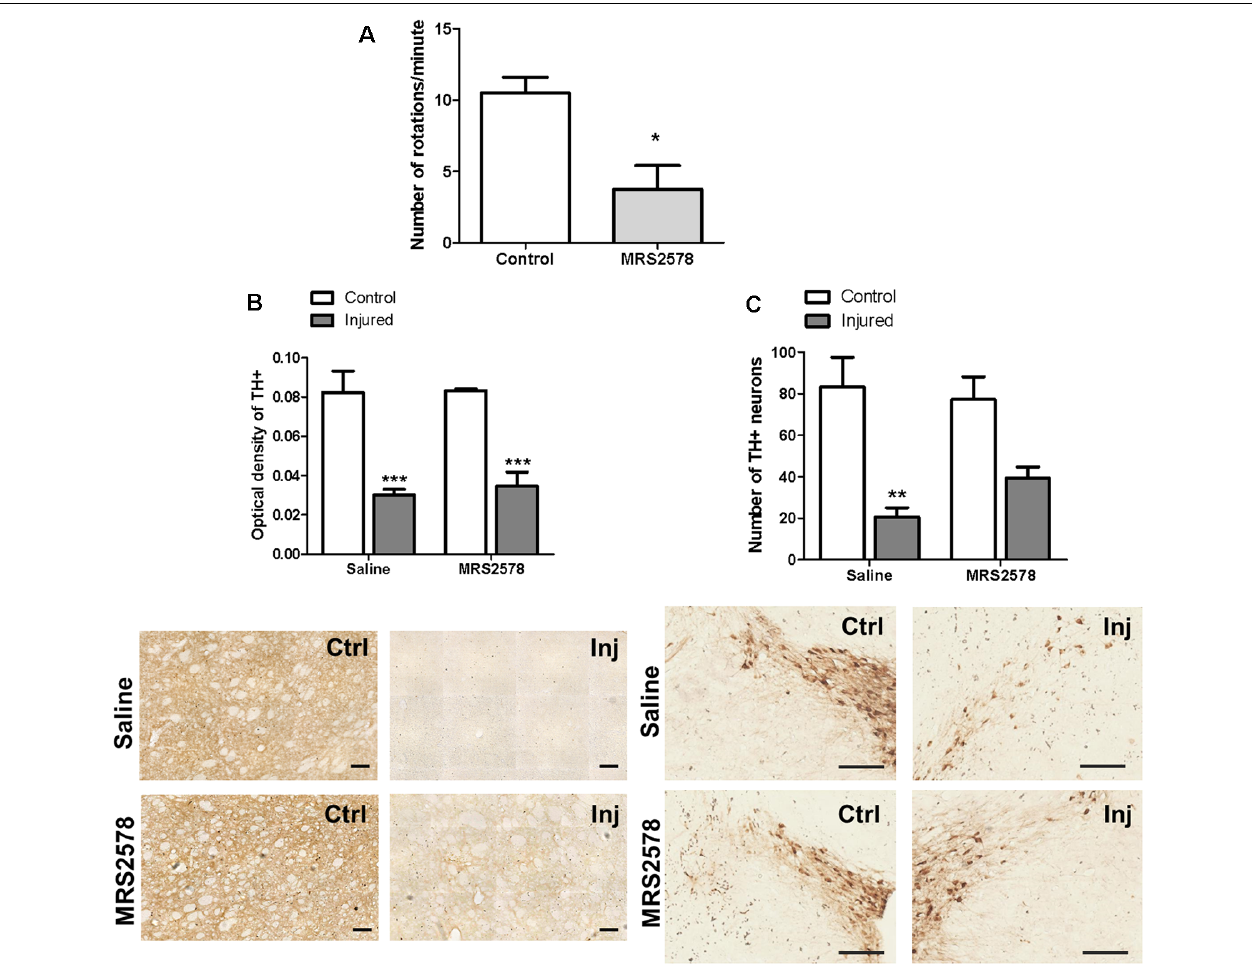
FIGURE 5 | Effect of MRS2578 treatment on 6-OHDA-injured rats. (A) MRS2578 at a dose of 2 µ g/kg was intrastriatally injected 10 min before ( n = 8) or 5 weeks after ( n = 5) the 6-OHDA at 7 µ g/kg injection. Animals were submitted to the apomorphine-induced rotational test after 1 week. ∗ p < 0.05 in relation to the number of pre-treatment rotations, F ( 2,18 ) = 4.299, p = 0.029. One-way ANOVA followed by the Tukey post hoc test. Immunohistochemical analysis of tyrosine hydroxylase labeling in the striatum (B) , measured as optical density, scale: 100 µ m, F ( 1,20 ) = 4.109, p = 0.056; and (C) in the substantia nigra , expressed by the number of neurons, scale: 200 µ m; F ( 1,20 ) = 7.751, p = 0.011. Control (Ctrl) and injured (Inj) hemispheres. Data are expressed as mean values ± standard errors of the mean. ∗∗∗ p < 0.001, ∗∗ p < 0.01 in relation to the respective control hemisphere; n = 6 for each group. Two-way ANOVA followed by the Bonferroni post hoc